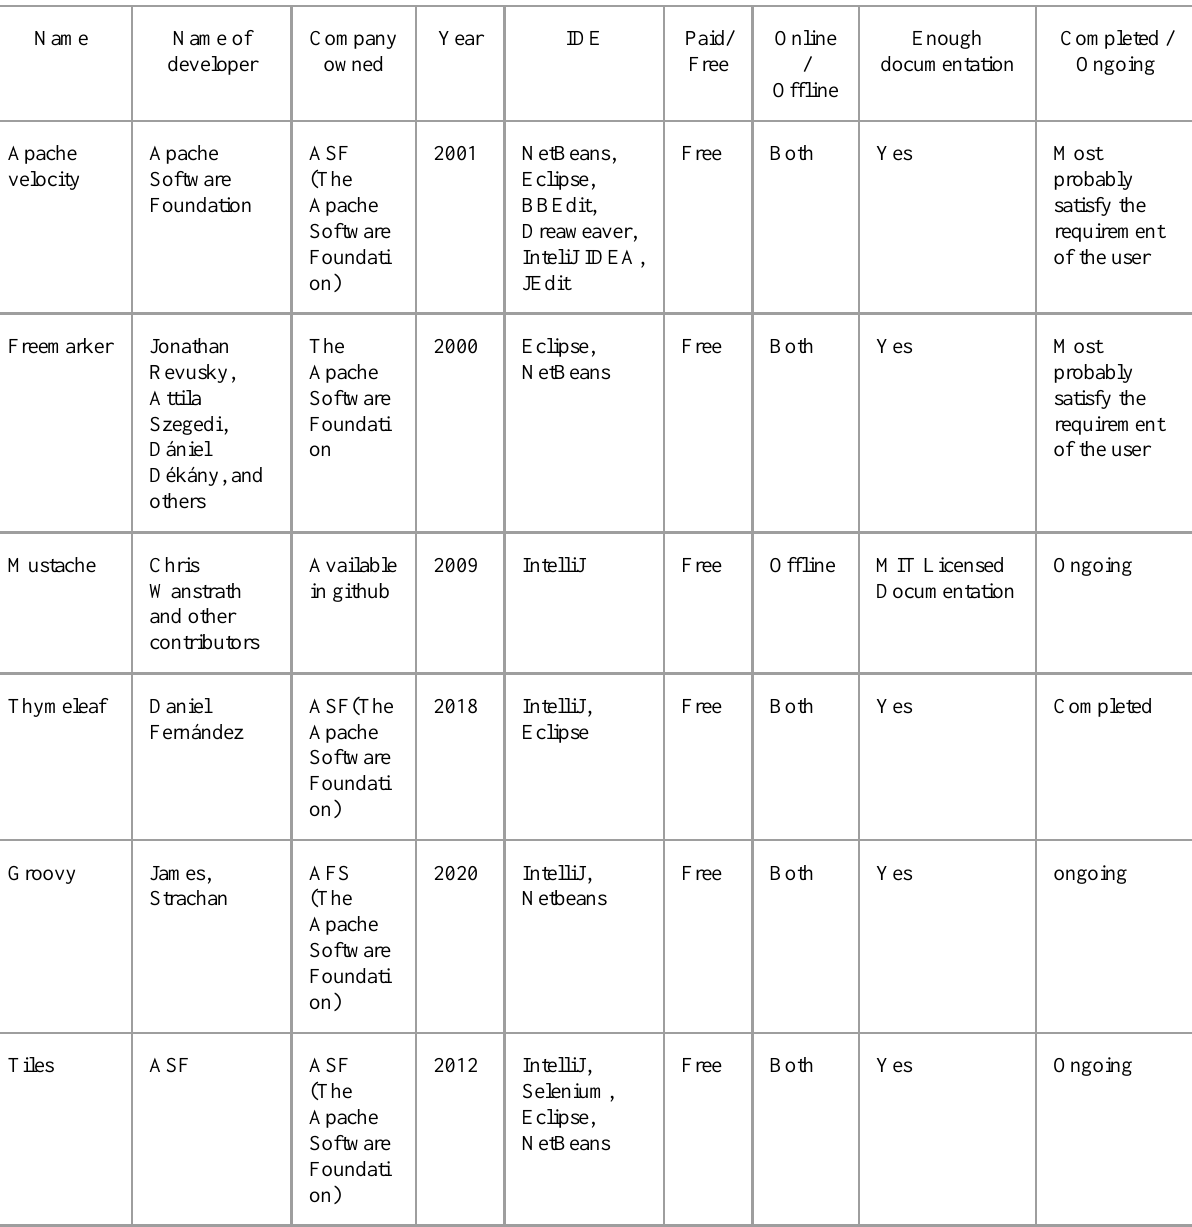
Table 2. Comparison of Different Template Engines in